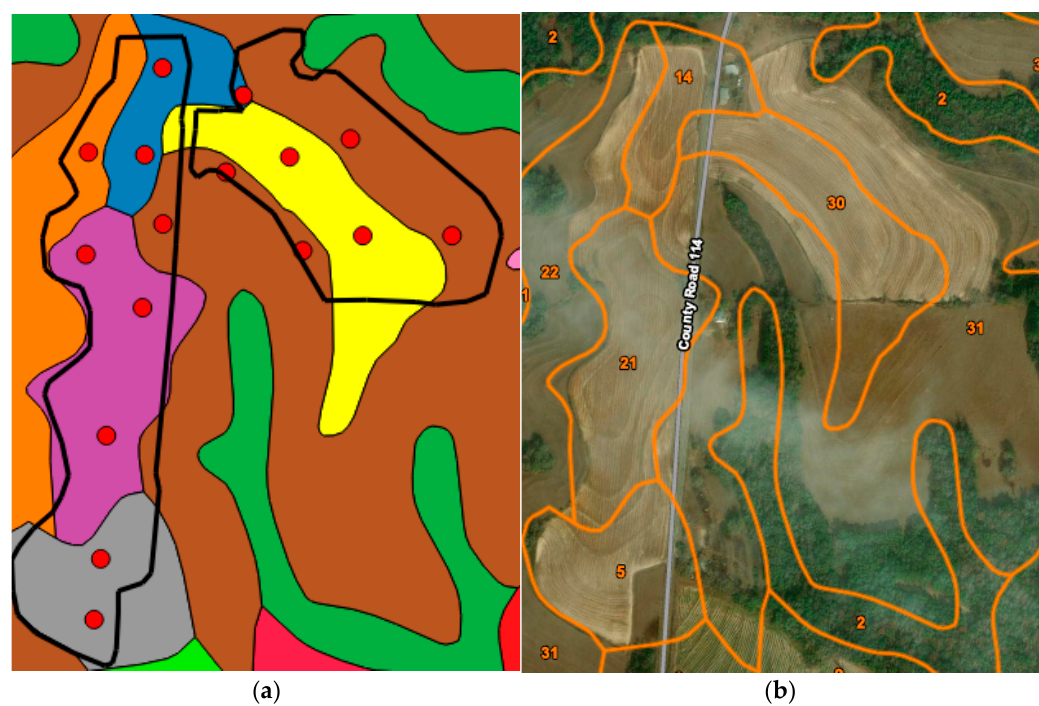
Figure 2. Map ( a ) showing field observation locations (red dots), field boundaries (black lines) and soil series (colors). ( b ) Aerial photo showing soil series boundaries (orange lines) and numbers, details of soil series based on numbers in https://websoilsurvey.nrcs.usda.gov/app/WebSoilSurvey.aspx (accessed on 14 August 2022) given in Table 1.